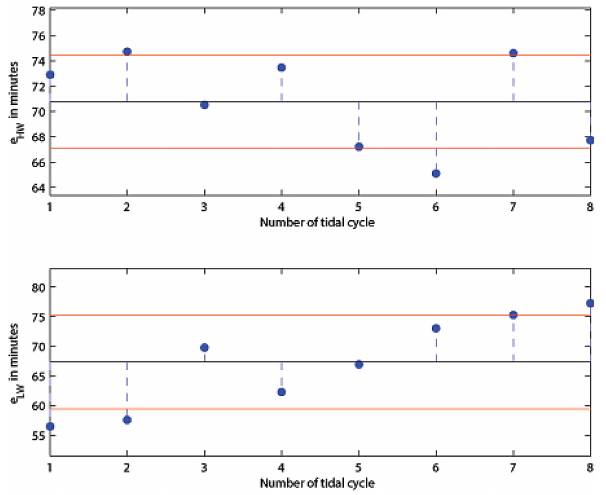
Figure 11. These graphs show the high-water phase lag ε hw and low-water phase lag ε lw at the location of buoy 18 in the Scheldt Estuary (in the vicinity of Terneuzen). The results are based on the Trimble R7 data which are processed in EGNOS mode using the Pe- gasus software (Butzmuehlen et al., 2001) after the measurements were taken. This implies that the accuracy of the processed results is equivalent to that of the proposed medium-range receiver, i.e. the Septentrio AsteRx1, in combination with a survey antenna operat- ing in EGNOS mode. The moment of slack tide is found with hy- pothesis testing using a significance level α of 0.05. The moment of high water is derived from a tidal observation station in Terneuzen (Rijkswaterstaat – RWS). The black line represents the mean phase lag based on eight observations. The results of the estimated high- water phase lag have a standard deviation of 4.7min. For the esti- mates of the low-water phase lag this is slightly larger: σ =7.5min. This is shown by the red line in the graph. Observation period runs from 1 to 5 July 2011.